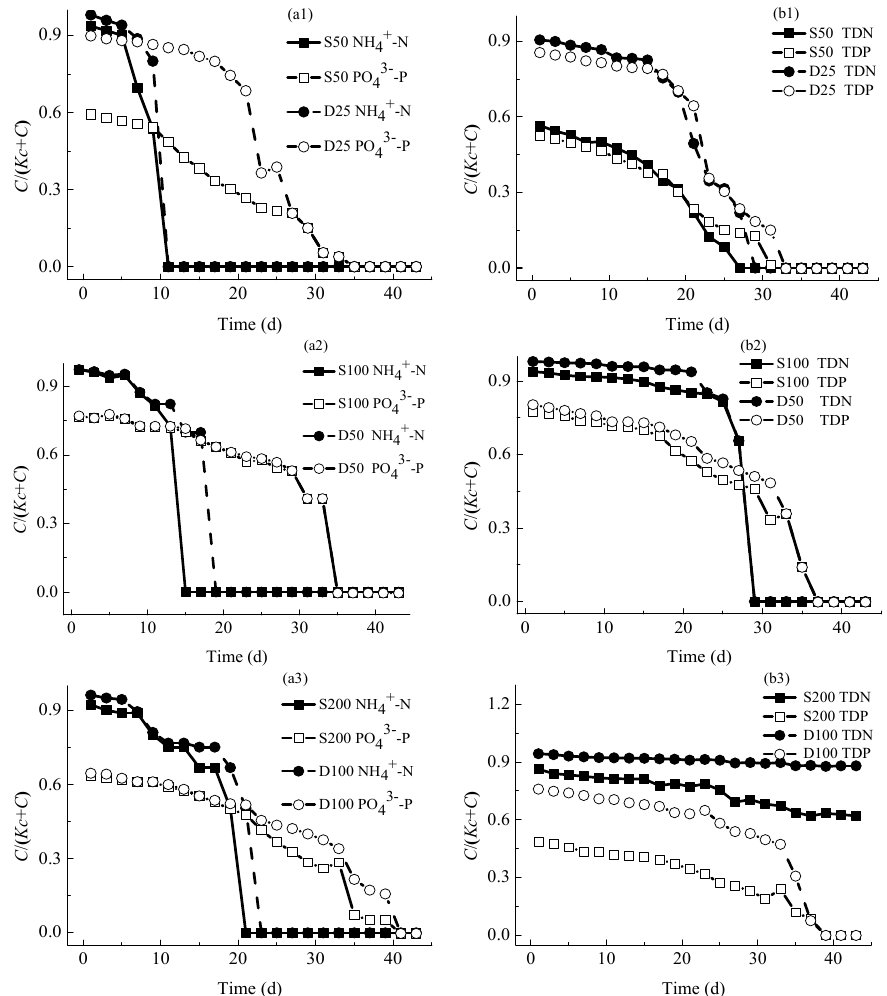
Figure 5. Variations of C /( K c + C ) with time: ( a1 – a3 ), NH 4+ -N and PO 43− -P; ( b1 – b3 ), TDN and TDP. A common phenomenon in natural water bodies is the shift of nutrient restrictions [52]. The pattern of nutrient limitation also shows a transformation in this study. As shown in Figure 5, in most cases, C /( K c + C ) of nitrogen nutrients (NH 4+ -N and TDN) are higher than those of phosphorus nutrients (PO 43− -P and TDP) at the start of the experi- ment, and lower than C /( K c + C ) of phosphorus nutrients at the end of this experiment, indicating that the limiting nutrients are shifted from phosphorus to nitrogen during the experiment. This may be caused by the utilization of nitrogen and phosphorus nutrients by M. aeruginosa . But the nitrogen limitation is not clear in some cases (e.g., S200 or D100). The above shift is the same for different prometryn exposure schemes. This is because the scenarios of prometryn exposure do not change the proportion of nitrogen and phospho- rus nutrients, different scenarios of prometryn exposure do not change the nutrient limi- tation shift, as expected.